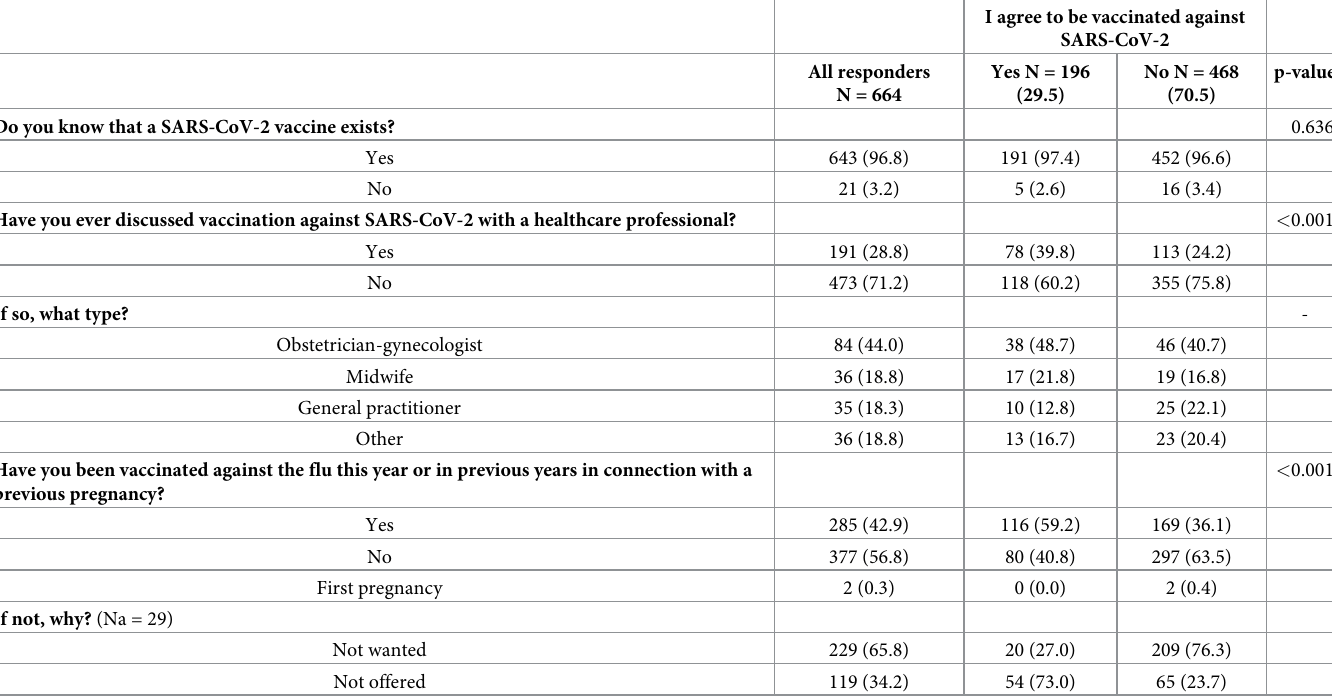
Table 4. Exposure and knowledge of vaccination and perceptions of the SARS-CoV-2